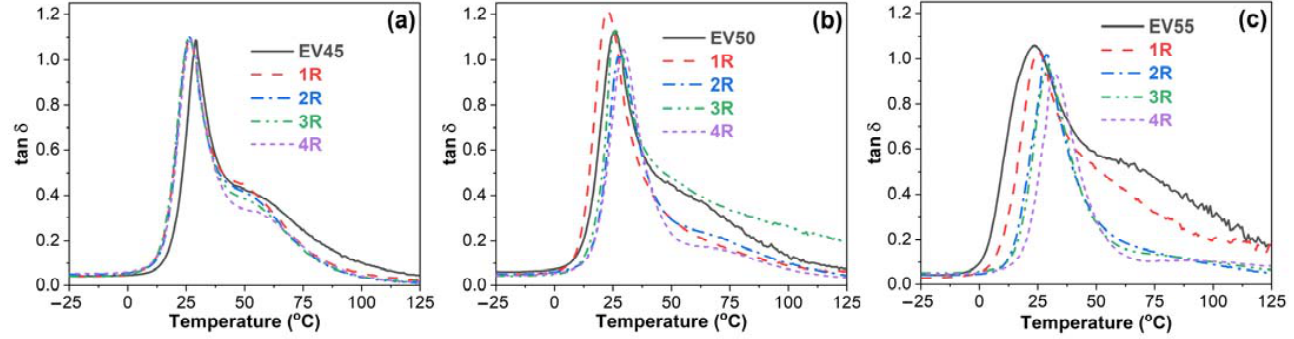
Figure 9. Damping factor versus temperature curves of the original and recycled epoxy vitrimers: ( a ) EV45, ( b ) EV50 and ( c ) EV55.